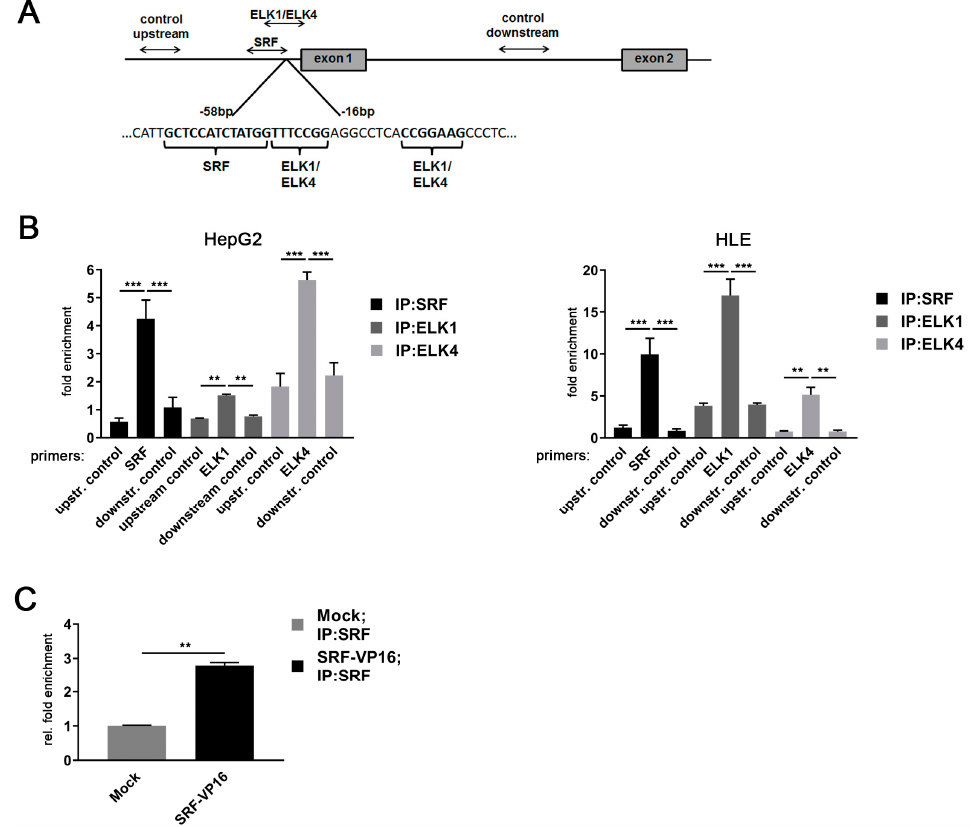
Figure 4. MDM4 gene promoter is activated by an SRF-ETS family transcription factor complex in HCC cell lines. ( A ) Schematic representation of the positioning of primers used for ChIP analyses of the MDM4 promoter region. ( B ) Specific binding of SRF, ELK1, and ELK4 at their cognate binding sites in the MDM4 promoter compared to control primers located either down- or upstream of the predicted basal MDM4 promoter as detected by quantitative real-time PCR of immunoprecipitated chromatin. ( C ) Relative enrichment of SRF-immunoprecipitated DNA in HuH7 cells transfected with SRF-VP16 expression plasmid compared to mock transfected control cells. Data are presented as mean ± SEM. Mann–Whitney U test: ** p < 0.01, *** p < 0.001. Abbreviations: upstr. control, control primer amplifying a region upstream of the MDM4 promoter; downstr. control, control primer amplifying a region downstream of the MDM4 promoter.